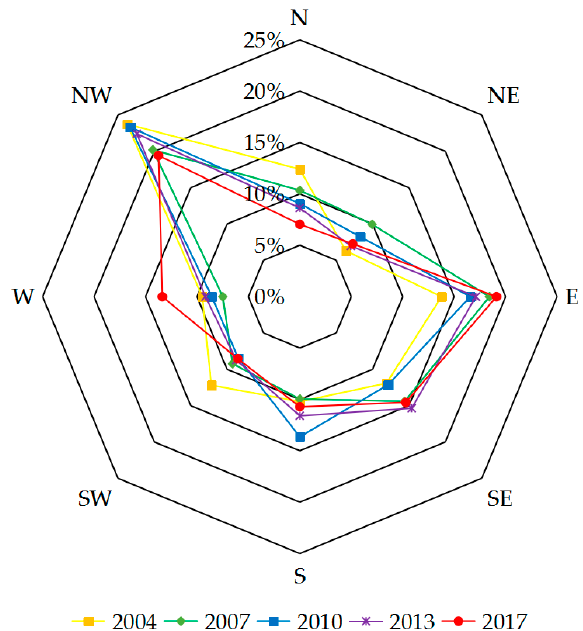
Figure 7. An eight-direction diagram of urban expansion intensity in Siem Reap from 2004 to 2017.